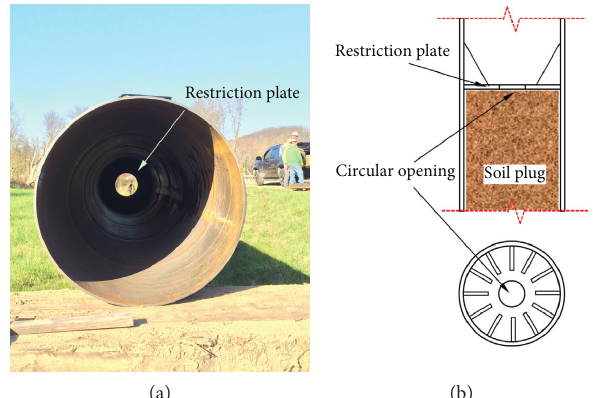
Figure 1: Large-diameter open-ended pipe pile with a donut-shaped restriction plate in New Philadelphia, Ohio.